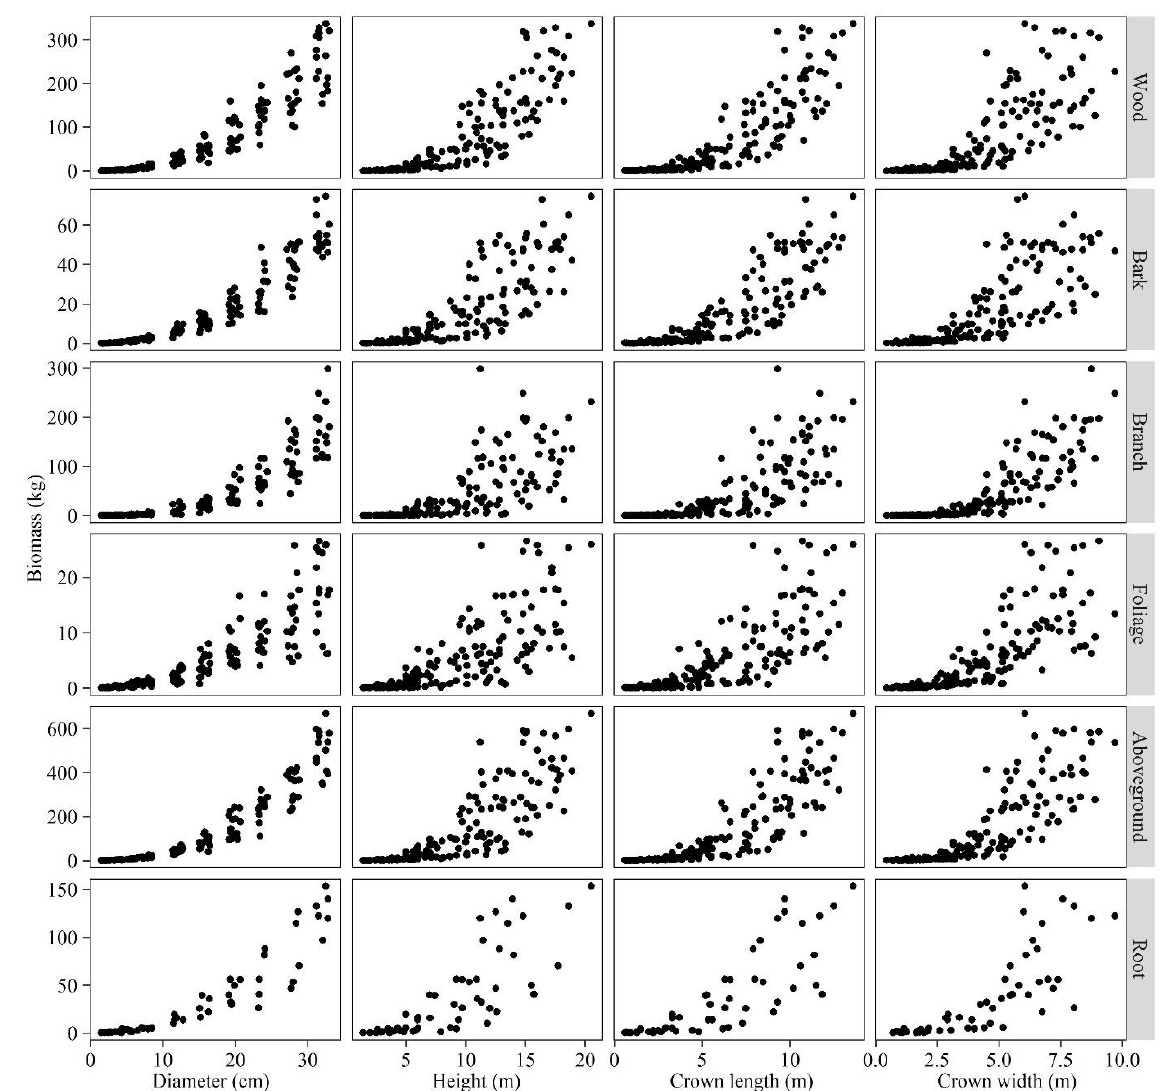
Figure 5. Relationships between the stem wood, bark, branch, foliage, aboveground and root biomass of the sampled trees and diameter, height, crown length and crown width. Table 3. Regression coefficients and statistics of the aboveground additive systems and root biomass equations with a specific weighting function.